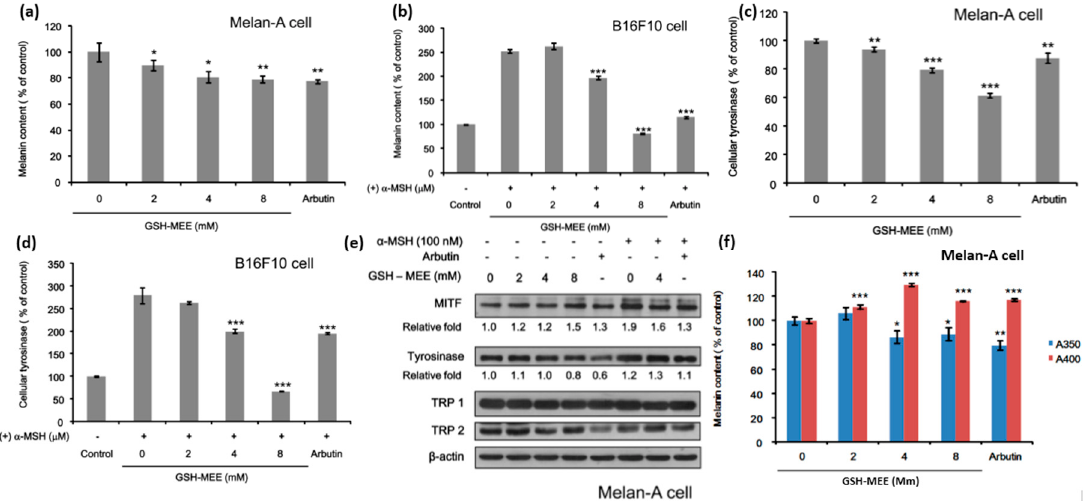
Figure 3. ( a ) Effect of GSH-MEE on melanin production in Melan-A cells. GSH-MEE decreased the production of melanin in a dose-dependent manner in Melan-A cells. Arbutin (100 µg/mL) was treated as a positive control. The melanin content was calculated by normalizing the melanin content to total cellular protein and reported as a percentage of control. Data are shown as the mean ± SD of three replicates, and * p < 0.05, ** p < 0.01. GSH-MEE, reduced glutathione monoethyl ester; SD, standard deviation; ( b ) Effect of GSH-MEE on melanin content in B16F10 cells. GSH-MEE decreased the amount of melanin produced by B16F10 cells. Arbutin (100 µg/mL) was treated as a positive control. The melanin content was calculated by normalizing the melanin contents to total cellular protein and reported as a percentage of control. Data are shown as the mean ± SD of three replicates, and *** p < 0.001. GSH-MEE, reduced glutathione monoethyl ester; α -MSH, α -melanocyte-stimulating hormone; SD, standard deviation; ( c ) Effect of GSH-MEE on intracellular tyrosinase activity in Melan-A cells. GSH-MEE decreased the activity of intracellular tyrosinase in a dose-dependent manner in Melan-A cells. Arbutin (100 µg/mL) was treated as a positive control. Each sample was quantified with the same amount of protein and reported as a percentage of control. Data are shown as the mean ± SD of three replicates, and ** p < 0.01, and *** p < 0.001. GSH-MEE, reduced glutathione monoethyl ester; SD, standard deviation; ( d ) Effect of GSH-MEE on intracellular tyrosinase activity in B16F10 cells. GSH-MEE decreased the activity of intracellular tyrosinase in B16F10 cells. Arbutin (100 µg/mL) was treated as a positive control. Each sample was quantified with the same amount of protein and reported as a percentage of control. Data are shown as the mean ± SD of three replicates, and *** p < 0.001. GSH-MEE, reduced glutathione monoethyl ester; α -MSH, α -melanocyte-stimulating hormone; SD, standard deviation; ( e ) Effect of GSH-MEE on the expression of melanogenesis-related proteins. When Melan-A cells were treated with GSH-MEE, the expression levels of MITF, tyrosinase, TRP-1, and TRP-2 did not change significantly. Arbutin (100 µg/mL) was treated as a positive control, and β -actin expression was used as the loading control. These results represents three independent experiments. GSH-MEE, reduced glutathione monoethyl ester; MITF, microphthalmia-associated transcription factor; TRP-1, tyrosinase-related protein-1; TRP-2, tyrosinase-related protein-2; ( f ) Effect of GSH-MEE on suggested eumelanin and pheomelanin production. When Melan-A cells were treated